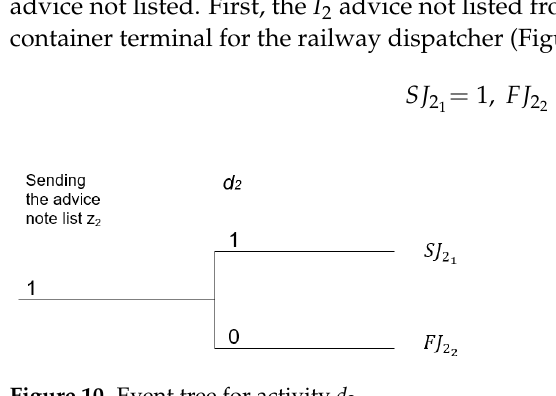
Figure 10. Event tree for activity d